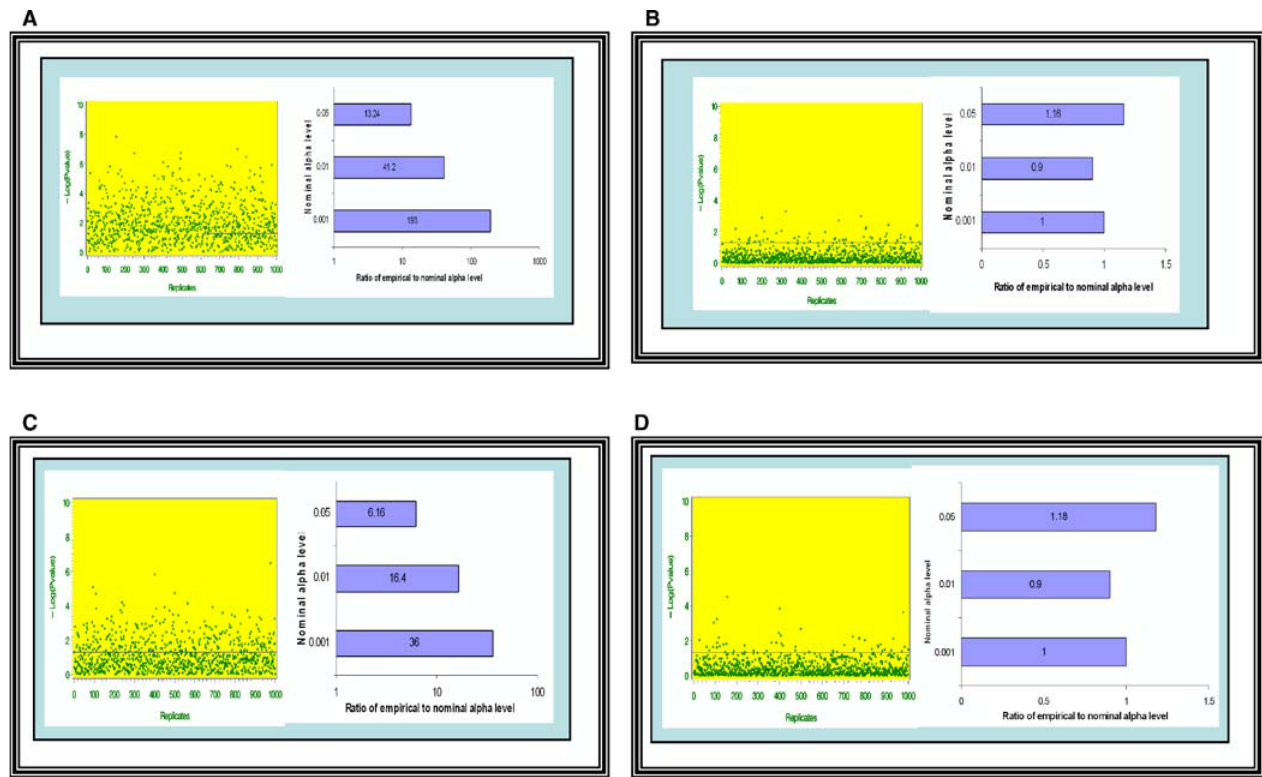
Figure 2. Conditioning on Individual Ancestry and the Product of Parental Ancestries Is Necessary and Sufficient to Control for Confounding A dataset was simulated from idealized circumstances for the purposes of illustration. The dataset contained 1,000 individuals that were admixed from parental populations V and V . For each individual, both parents had the same amount of V ancestry. The V ancestry proportion of each individual was drawn from a beta distribution (Beta [0.3771, 0.8341]). These parameter values were based on estimates of African ancestry proportions from a sample of 479 individuals recruited from different previously described studies in New York City, New York, and Birmingham, Alabama [66–68]. We simulated a trait-influencing diallelic QTL (G1) that had alleles G and g with frequencies 0.2 and 0.8, respectively, in population V and frequencies 0.8 and 0.2, respectively, in population V . We simulated a phenotype, Y, that was a function of G1 and a random normal deviate. Finally, we simulated a marker (G2) that had alleles with frequencies 0.2 and 0.8 in population V and complementary frequencies in population V . Alleles at G2 did not influence Y and G2 was unlinked to G1. However, G1, G2, and Y are all correlated with ancestry. However, the association between G2 and Y is spurious. We then test for association between Y and G2 by regressing Y on two dummy codes for the genotypes at G2 [69] and conducting a two degrees of freedom (df) test under the following scenarios: (1) without any type of control (i.e., no covariates); (2) controlling for linear term of true individual ancestry when the alleles at G1 act in an additive fashion; (3) controlling for linear term of true individual ancestry when the alleles at G1 act in an overdominant fashion; and (4) controlling for linear and quadratic term of true individual ancestry when the alleles at G1 act in an overdominant fashion. Because we imposed the simplifying condition that for each individual, both parents had the same amount of V ancestry, the square of individual ancestry is equivalent to the product of parental ancestries. Since alleles at G2 do not cause variation in Y nor is G2 linked to a gene that causes variation in Y, every significant association found under any of the above scenarios constitutes a false positive. The graphs in this panel were created by simulating 1,000 independent replicate datasets. The dots on each graph located on the left portion of each panel represent the observed p values (expressed on a (cid:1) log 10 scale) for the test for the effect of G2 for each dataset. The bar plot of the right section of each panel represents the observed ratio of the empirical to the nominal type I error for each simulation. (A) Not controlling for ancestry leads to inflated type I error. The degree of type 1 error rate inflation increases with smaller a levels. (B) Controlling for only the linear term of individual ancestry is sufficient only when the confounding QTL affects the phenotype only in an additive fashion. In this case, there was no excess of type 1 errors. (C) When the QTL affects the phenotype in a nonadditive fashion (in this case, through overdominance), controlling for the linear term of ancestry is insufficient to remove the confounding effect. The type I error rates remain quite inflated even after including true individual ancestry in the model. (D) When the QTL affects the phenotype in an overdominant fashion, controlling for true individual ancestry and the product of parental ancestries effectively eliminates the confounding. In this case, the ratios of empirical to nominal a levels are within sampling error of 1.0. DOI: 10.1371/journal.pgen.0020137.g002